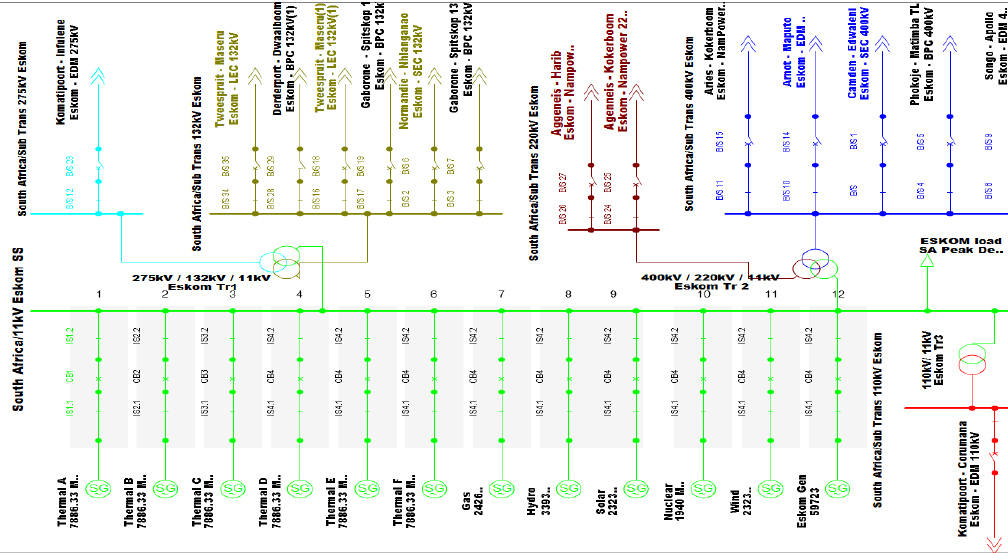
Figure 5. Southern African regional proposed network model.